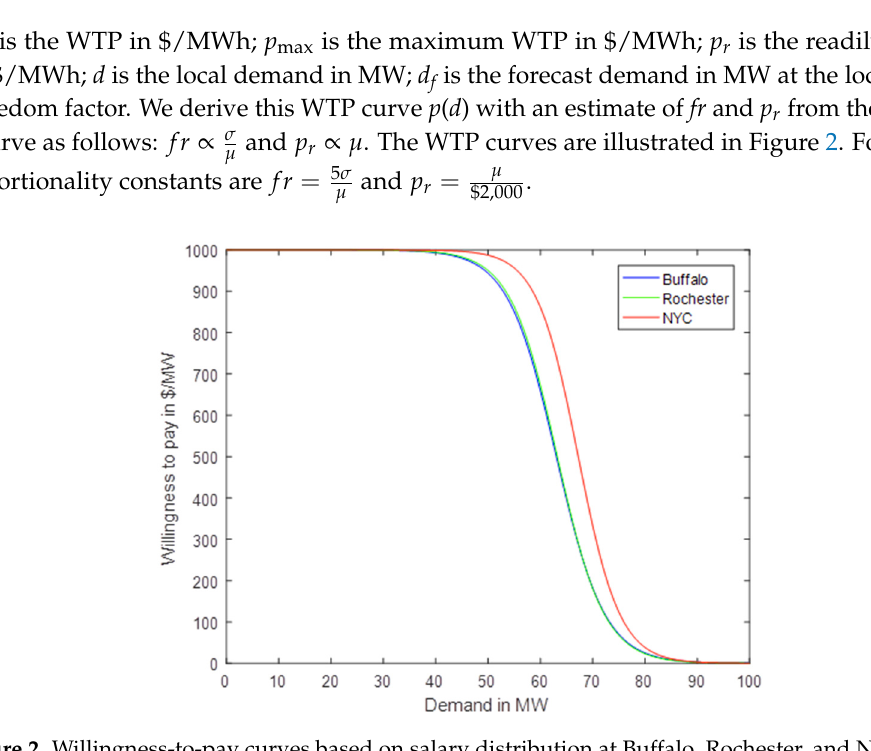
Figure 2. Willingness-to-pay curves based on salary distribution at Buffalo, Rochester, and New York City when the load forecasts are all 80 MW.